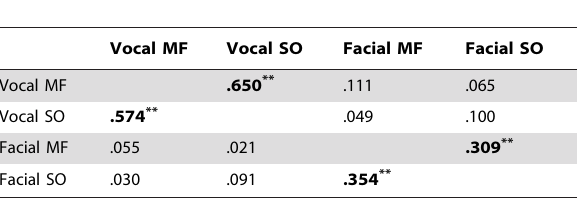
Table 2. Kendall’s Tau correlations between ratings of masculinity-femininity (MF) and sexual orientation (SO) based on ratings from vocal recordings (N =30) and facial images (N=